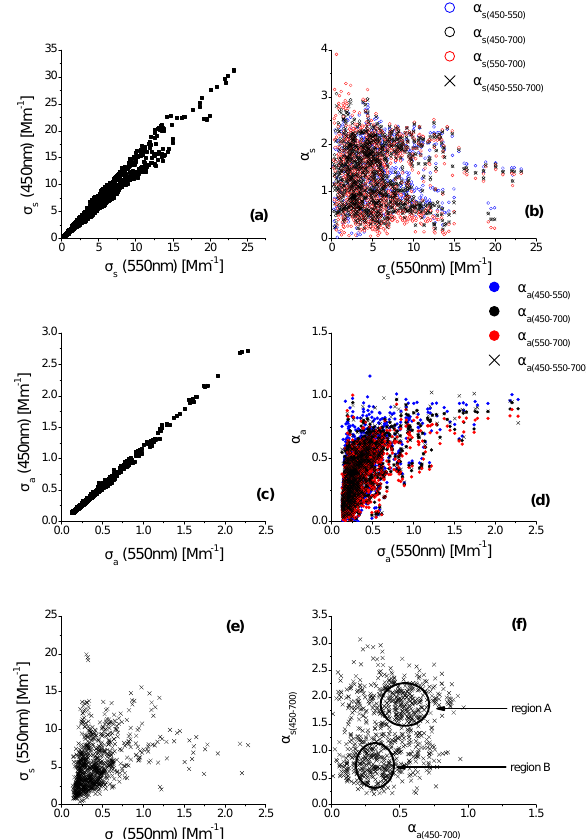
Fig. 5. (a, c) Hourly average values of the scattering and absorption for different wavelengths. (b, d) Hourly average values of the σ s and σ a as a function of the respective ˚Angstr¨om exponents. Relationship between the coefficients σ s and σ a (e) and between the slopes α s and α a (f)